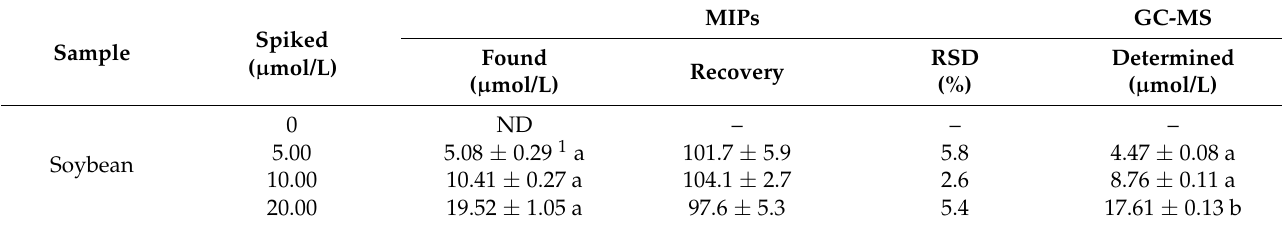
Table 1. Spiked recoveries and relative standard deviations (RSD, %, n = 3) for the determination of dimethoate in soybean with microfluidic paper chips and